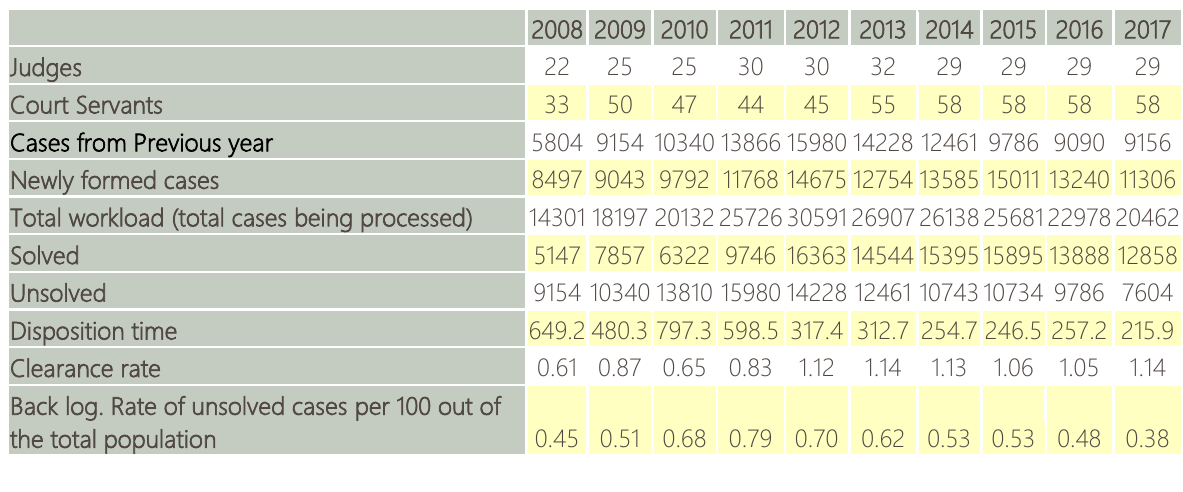
Table 4: Administrative Court